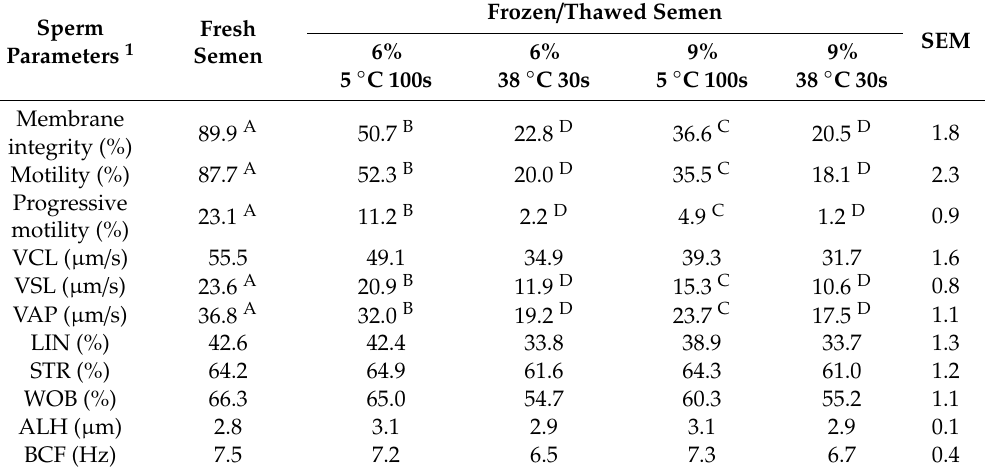
Table 2. Sperm quality parameters (LSMeans ± SEM) measured in fresh and frozen / thawed semen cryopreserved using di ff erent concentration of N-Methylacetamide and di ff erent thawing temperatures. Frozen / Thawed Semen Sperm Fresh Parameters 1 Semen